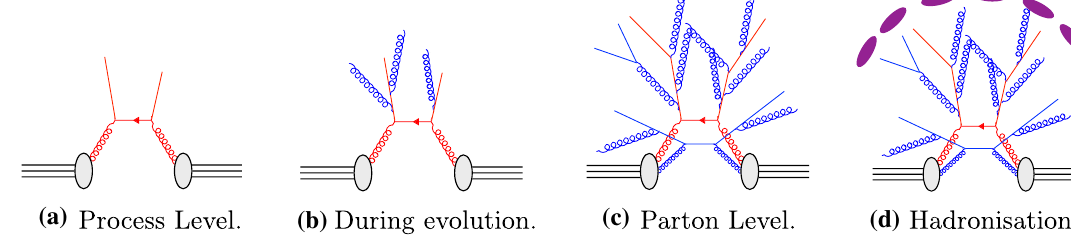
case of double flavour excitation, b and ¯ c quarks shown at the top and bottom represents the companion quark produced as a result of the initial-state evolution